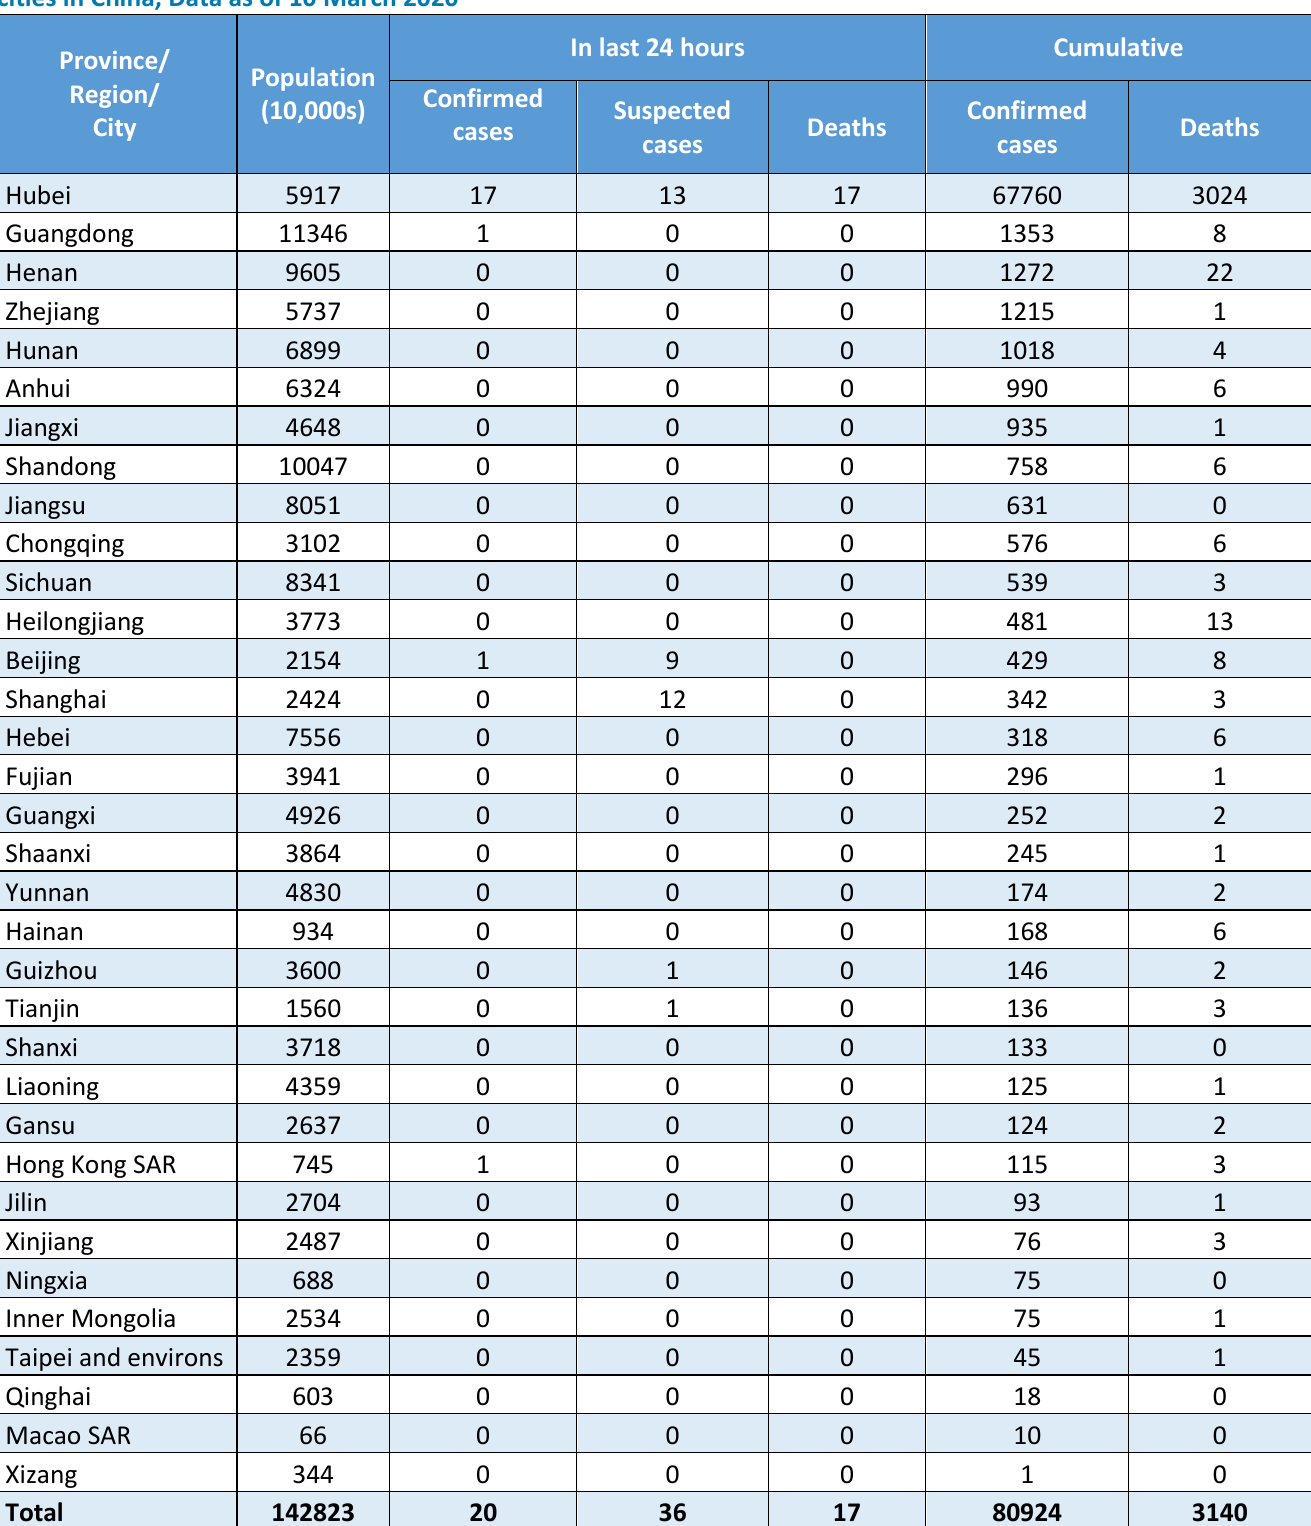
Table 1. Confirmed and suspected cases of COVID-19 acute respiratory disease reported by provinces, regions